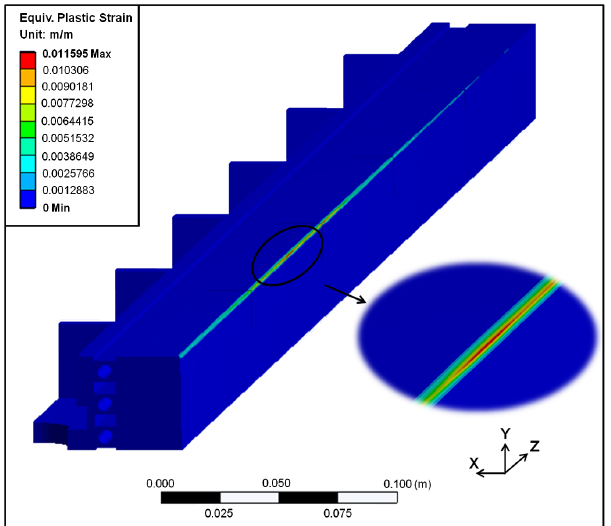
FIG. 24. Equivalent plastic strains on the collimator jaw assembly after the beam impact. A detailed view is shown in the inset.